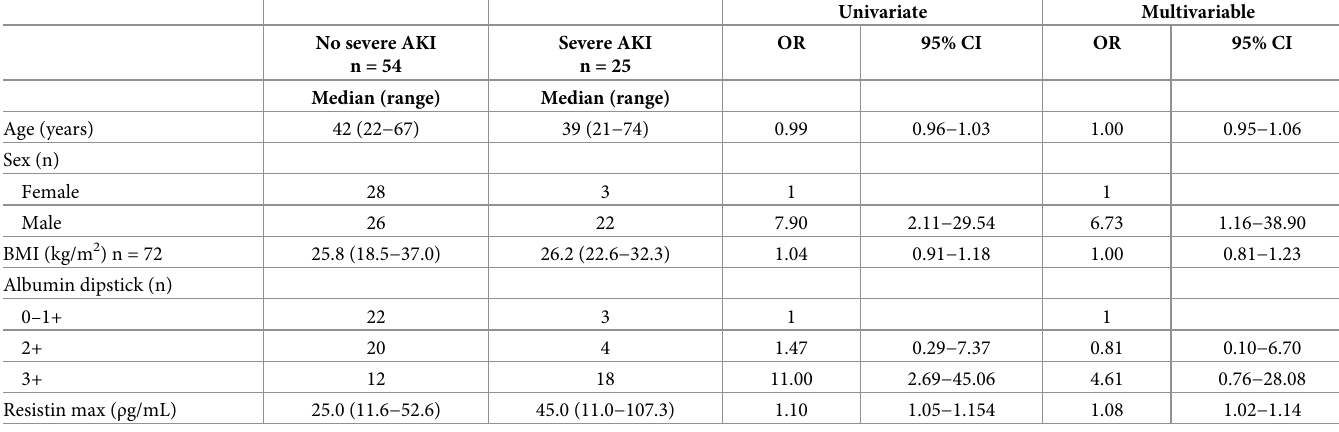
Table 5. Multivariate logistic regression analysis of risk factors for severe AKI (plasma creatinine � 353.6 μ mol/L) among 79 hospitalized patients with acute Puu- mala hantavirus